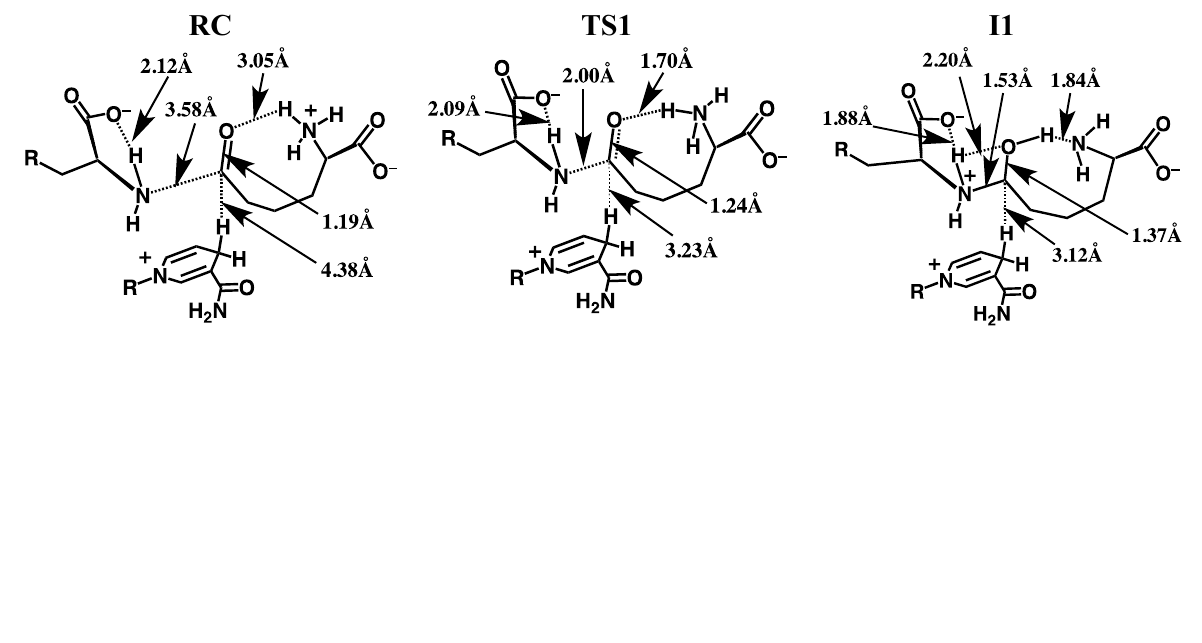
Figure 4. Optimized structures obtained at the ONIOM(HF/6-31G(d):AMBER94)-ME level of theory of the reactant complex ( RC ), transition structure ( TS1 ) and the carbinolamine intermediate I1 with selected distances shown (in